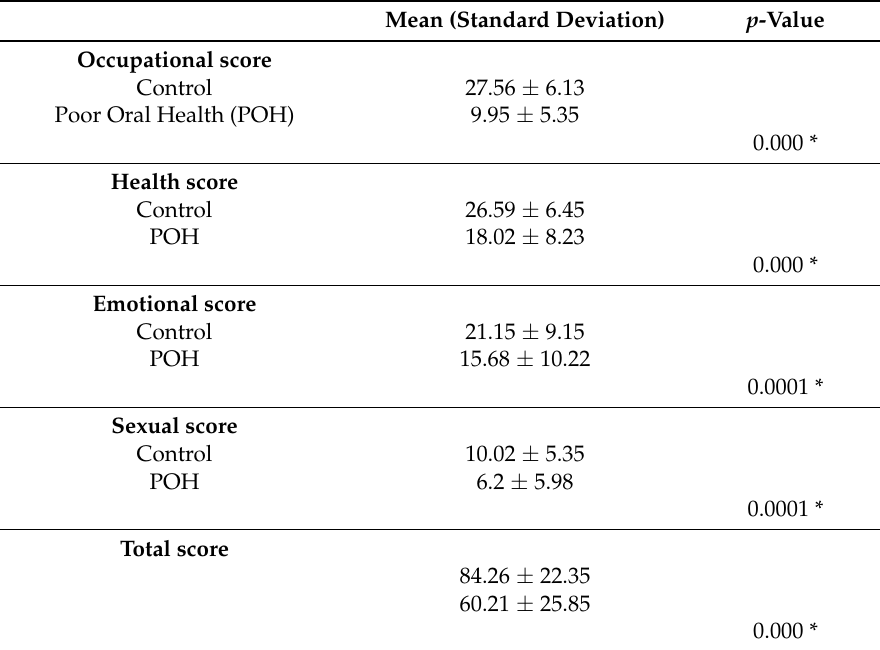
Table 5. Quality of life scores in the poor oral health group versus the